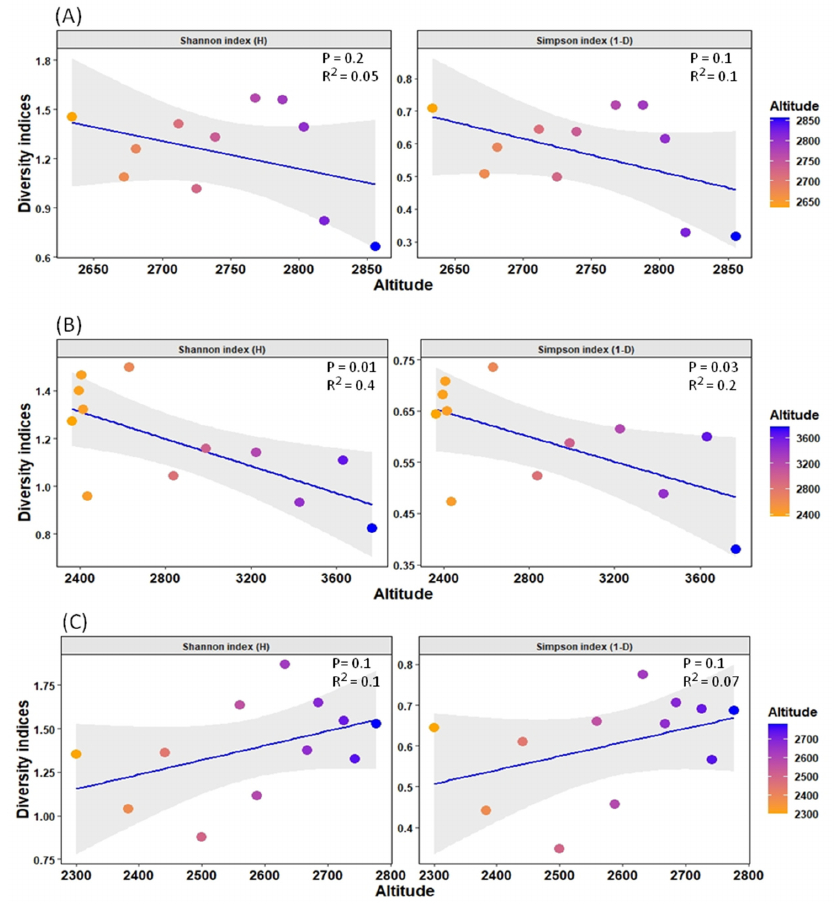
Figure 6. Relationship between diversity indices (Shannon index (H) and Simpson index (1-D)) and altitude gradient for each stream. The grid colors represent low and high altitudes in the graph. ( A ) BZL stream, ( B ) SR stream, and ( C ) YR stream.